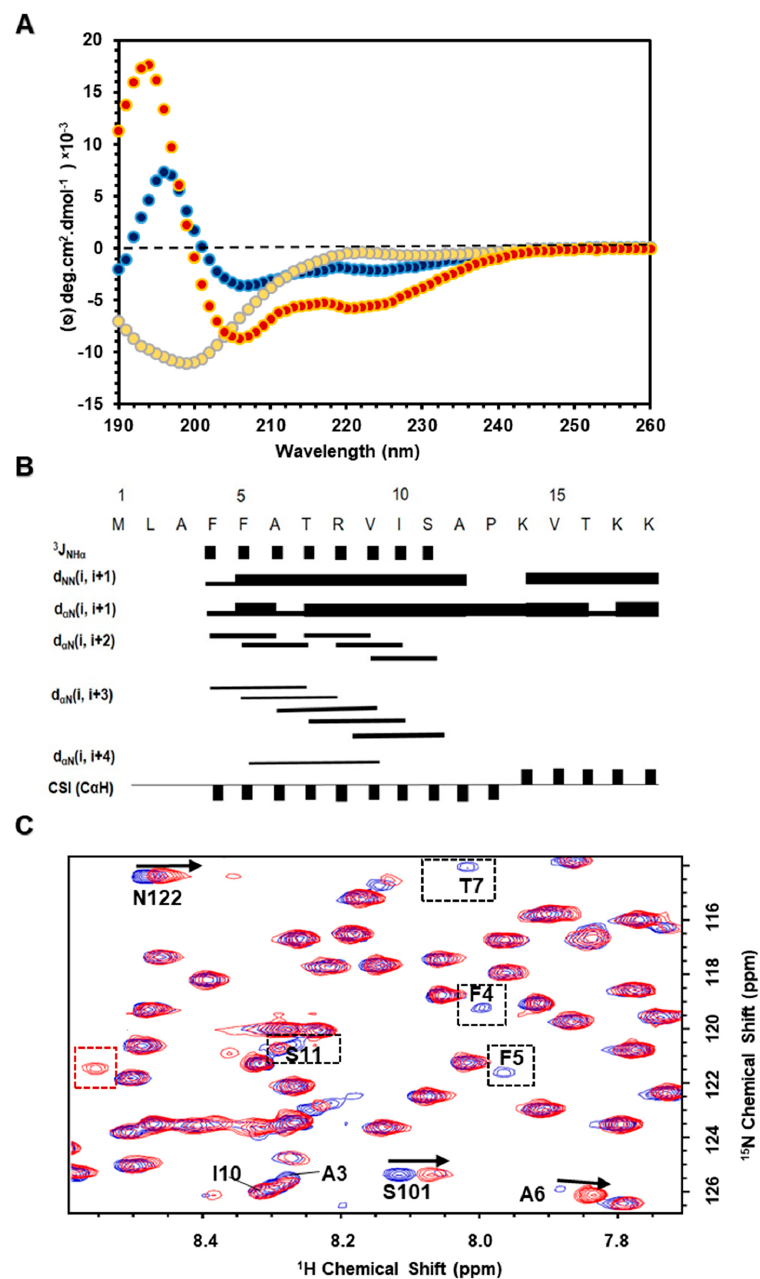
Figure 8. ( A ) Comparison of CD spectra for Tv CyP2 3–18 peptide in aqueous buffer (yellow), 30% Trifluoroethanol (TFE) (red) and sodium dodecyl sulfate (SDS) micelles (blue) shows that Tv CyP2 3–18 in TFE and SDS micelles forms an α -helical structure because two minimum absorbances at 208 and 222 nm are observed in their spectra. ( B ) Summary of the structural statistics of Tv CyP2 3–18 peptide in 30% TFE showing the primary sequence, 3 J NH α coupling constants, intensities of particular NOE connectivities, and C α H chemical shift index. 3 J NH α coupling constants < 6 Hz are indicated by filled squares. Bar thickness indicates the intensity of Nuclear overhauser effect (NOE) connectivity, with a thicker bar representing stronger NOEs. The negative bars in the chemical shift index indicate upfield shifts of > 0.1 ppm of the C α H as compared with the expected random-coil C α H chemical shift. The positive bars indicate downfield shifts of > 0.1 ppm of the C α H as compared with the expected random-coil C α H value. ( C ) A partial region of the 2D 1 H- 15 N HSQC spectra of Tv Cyp2 in aqueous solution overlapped with that in DPC micelles (Figure S5A). Residues showing chemical shift perturbation or line width broadening are